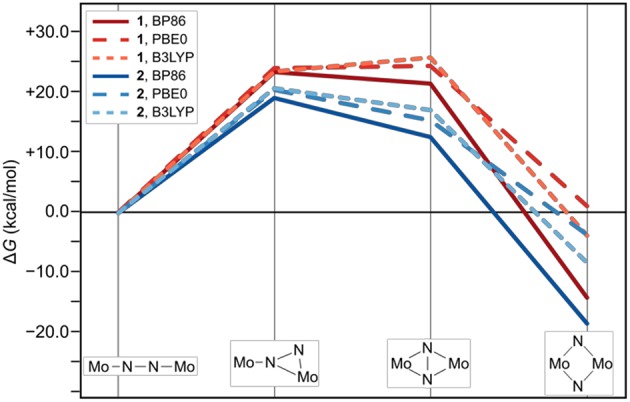
Thermodynamic profile of the isomerization paths for 1 (red) and 2 (blue). Data points for which the electronic structures are calculated with PBE0 and B3LYP are long-dashed and short-dashed, respectively.